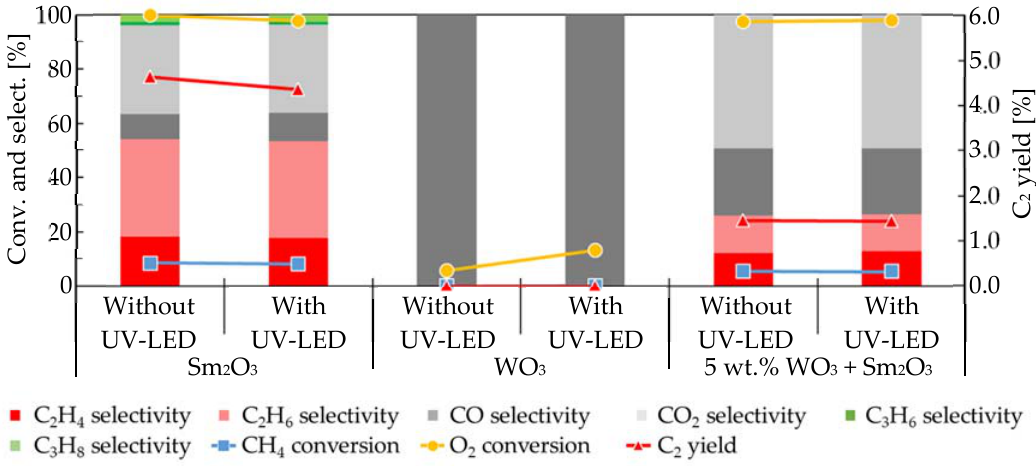
Figure 2. E ff ects of UV-LED irradiation on the oxidative dehydrogenation of methane when using Sm 2 O 3 , WO 3 , and 5 wt.% WO 3 + Sm 2 O 3